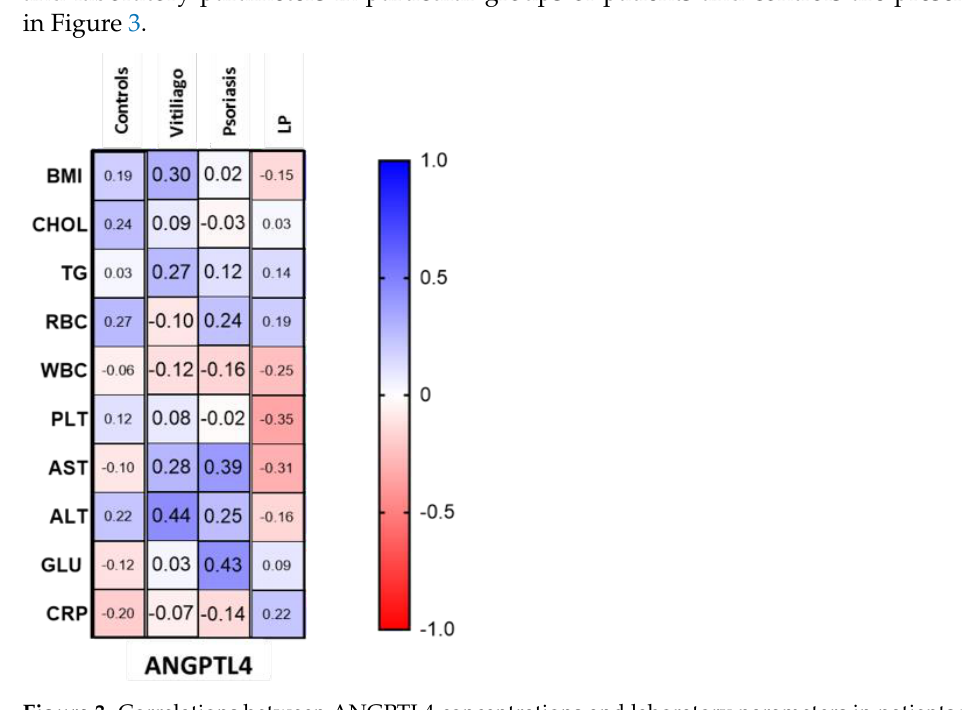
Figure 3. Correlations between ANGPTL4 concentrations and laboratory parameters in patients with vitiligo, psoriasis and lichen planus, as well as in controls.